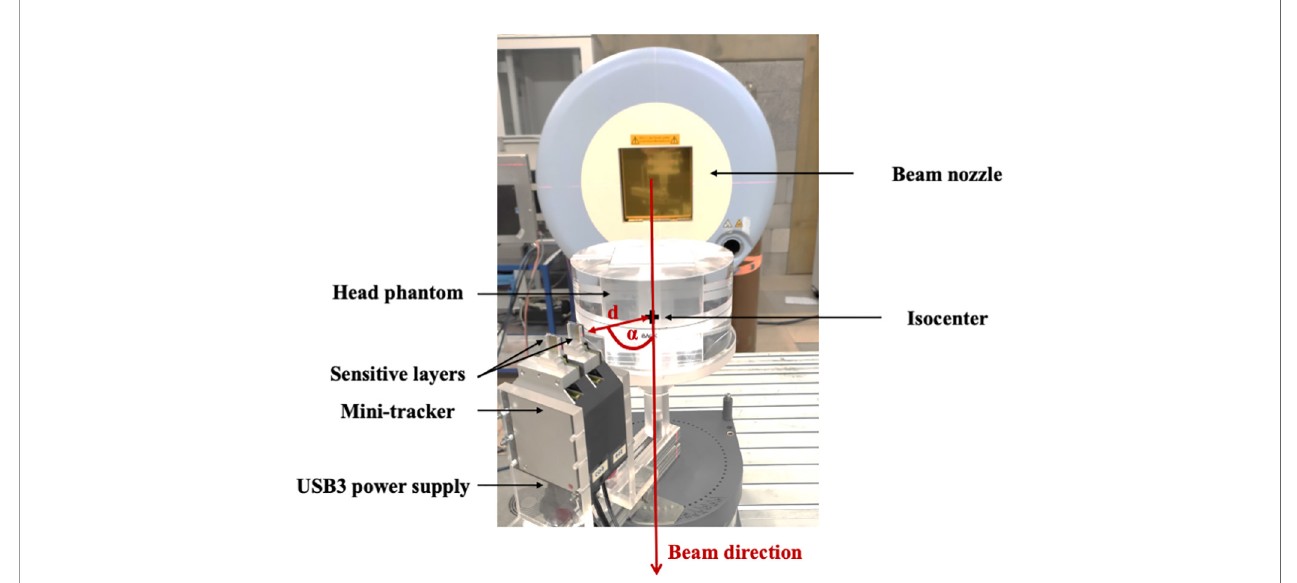
FIGURE 1 | A head phantom composed of PMMA was irradiated with a clinic-like carbon-ion treatment fi eld. Charged fragments were detected by a mini-tracker based on two Timepix3 chips. Several positions of the mini-tracker, characterized by the distance d between the front detector and the isocenter as well as the angle a with respect to the beam direction, were